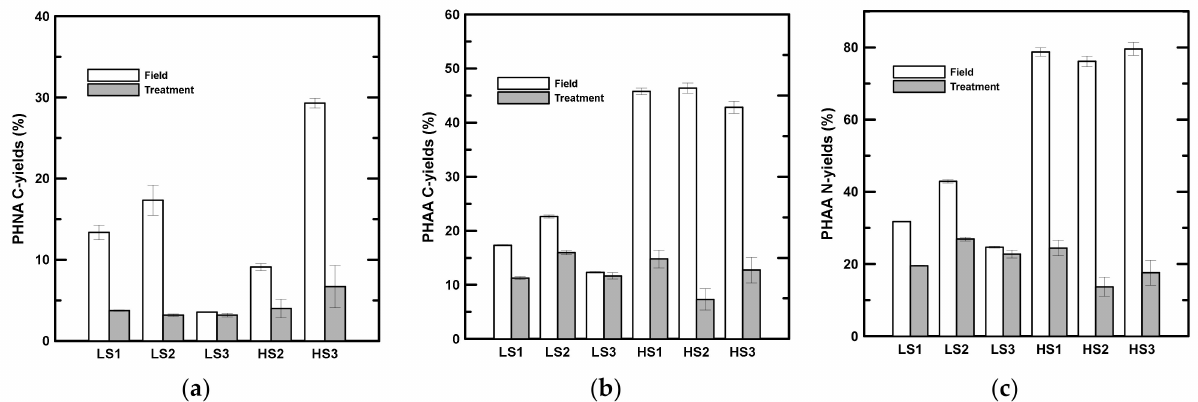
Figure 2. C- and N-yields of labile organic components in the particulate phase. ( a ) C-yields of particulate hydrolysable neutral aldose (PHNA). Data is not available for HS1. ( b ) C-yields of particulate hydrolysable amino acid (PHAA). ( c ) N-yields of PHAA. LS and HS denote low- and high-salinity,